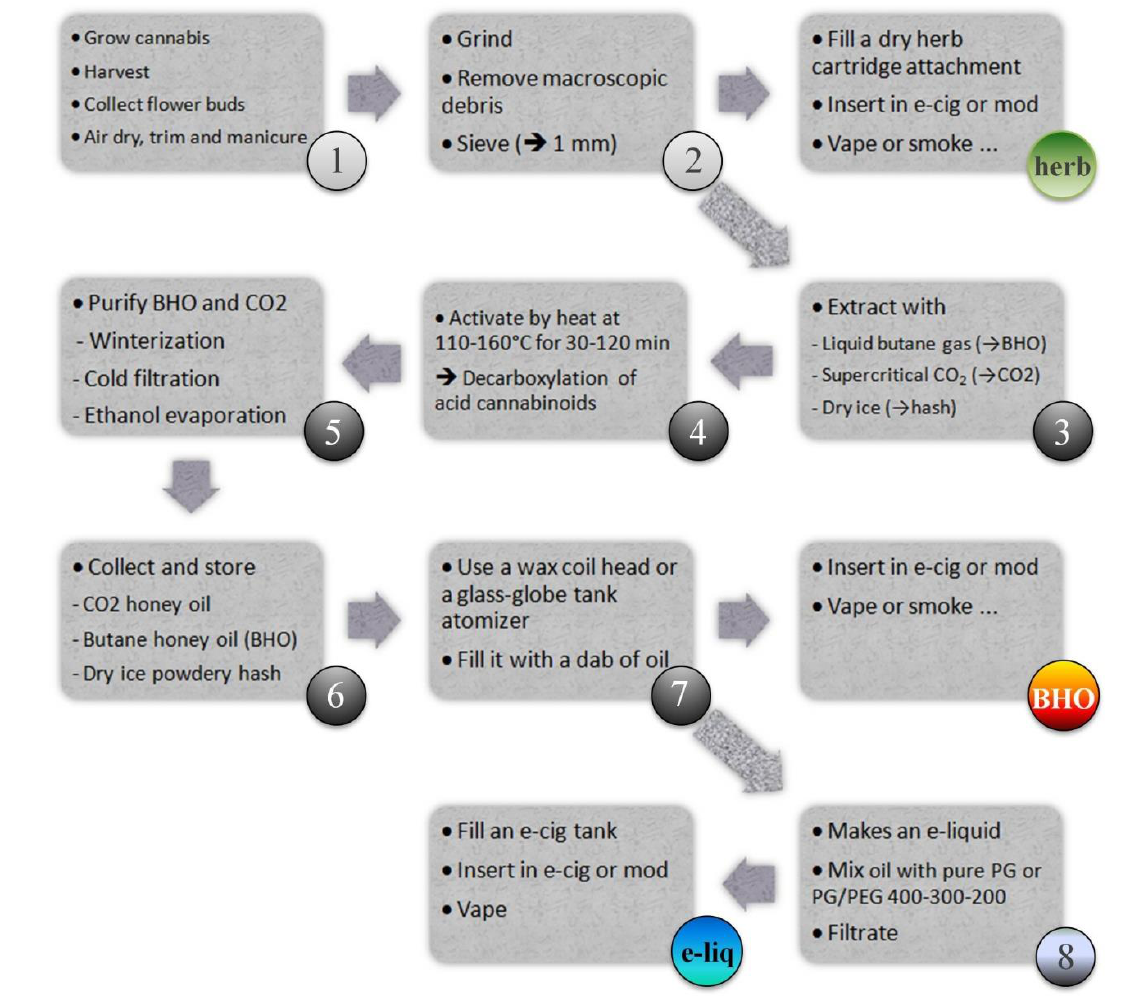
Figure 3. Manufacture of ground cannabis head buds, butane honey oil extract and cannabis e-liquid. 1–3. Processing cannabis heads and smoking them in a dry herb vaporizer;